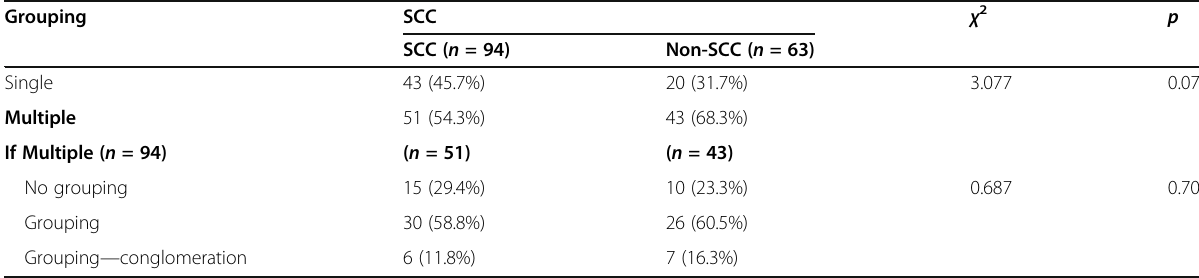
Table 6 Comparison between the two studied groups according to grouping Grouping